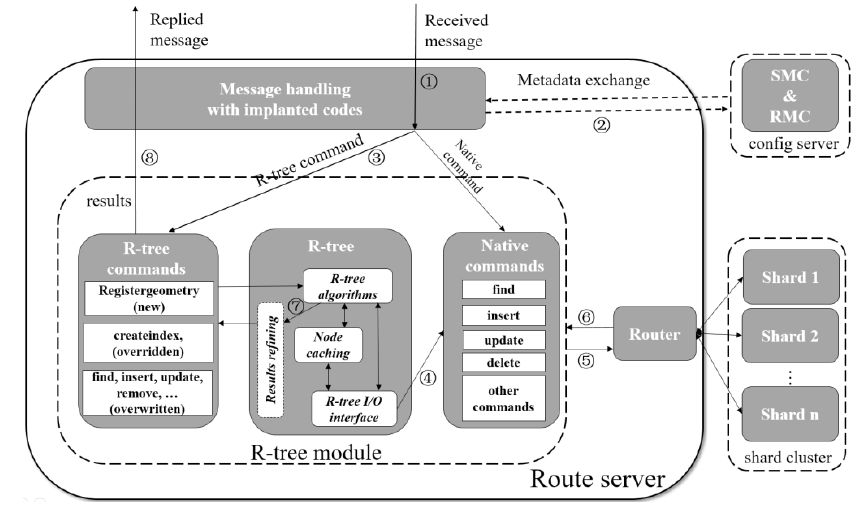
Figure 5. A typical workflow for R-tree-supported operations.